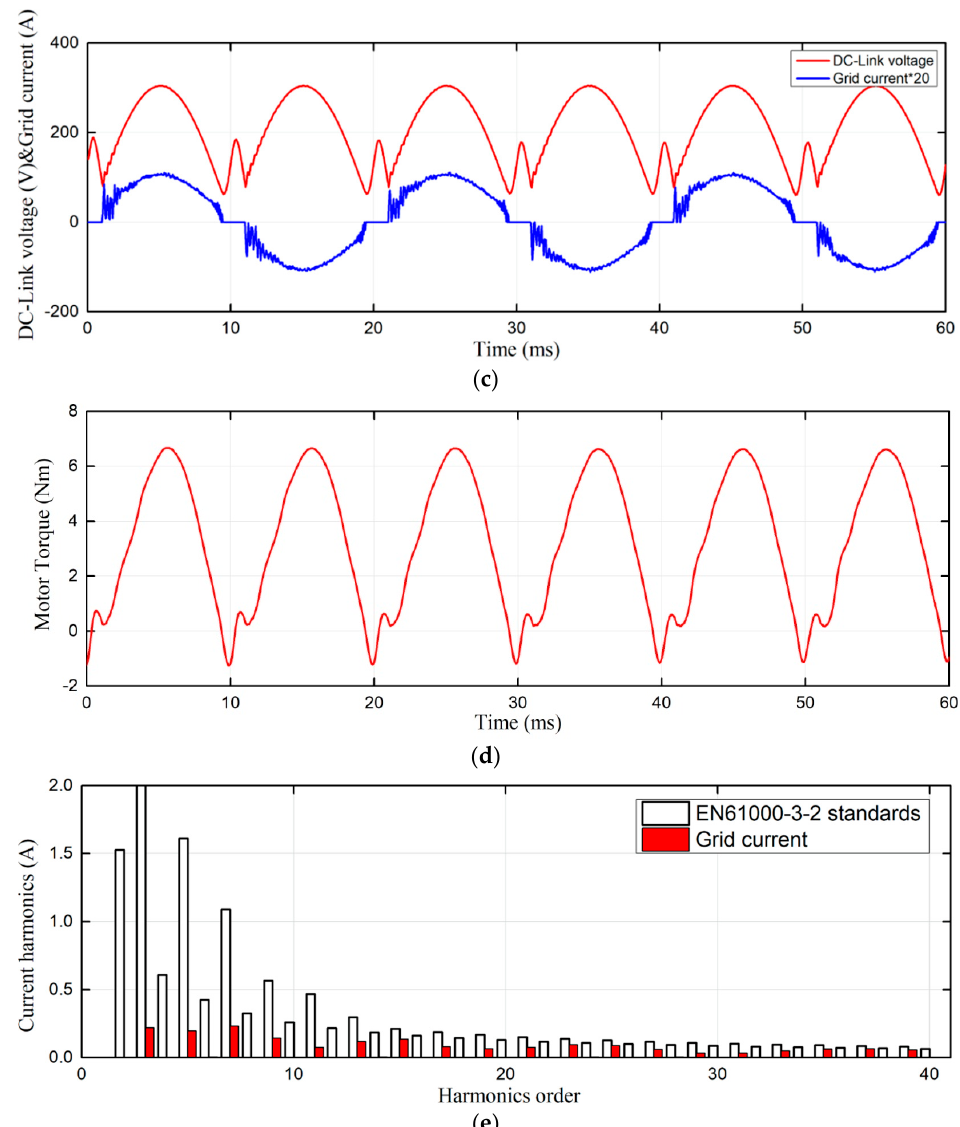
Figure 21. Simulation result of the FSMO estimate method with a PIR controller: ( a ) Motor Speed; ( b ) Position and estimated error; ( c ) DC-link voltage and grid current; ( d ) Motor output torque; ( e ) FFT analysis of grid current.